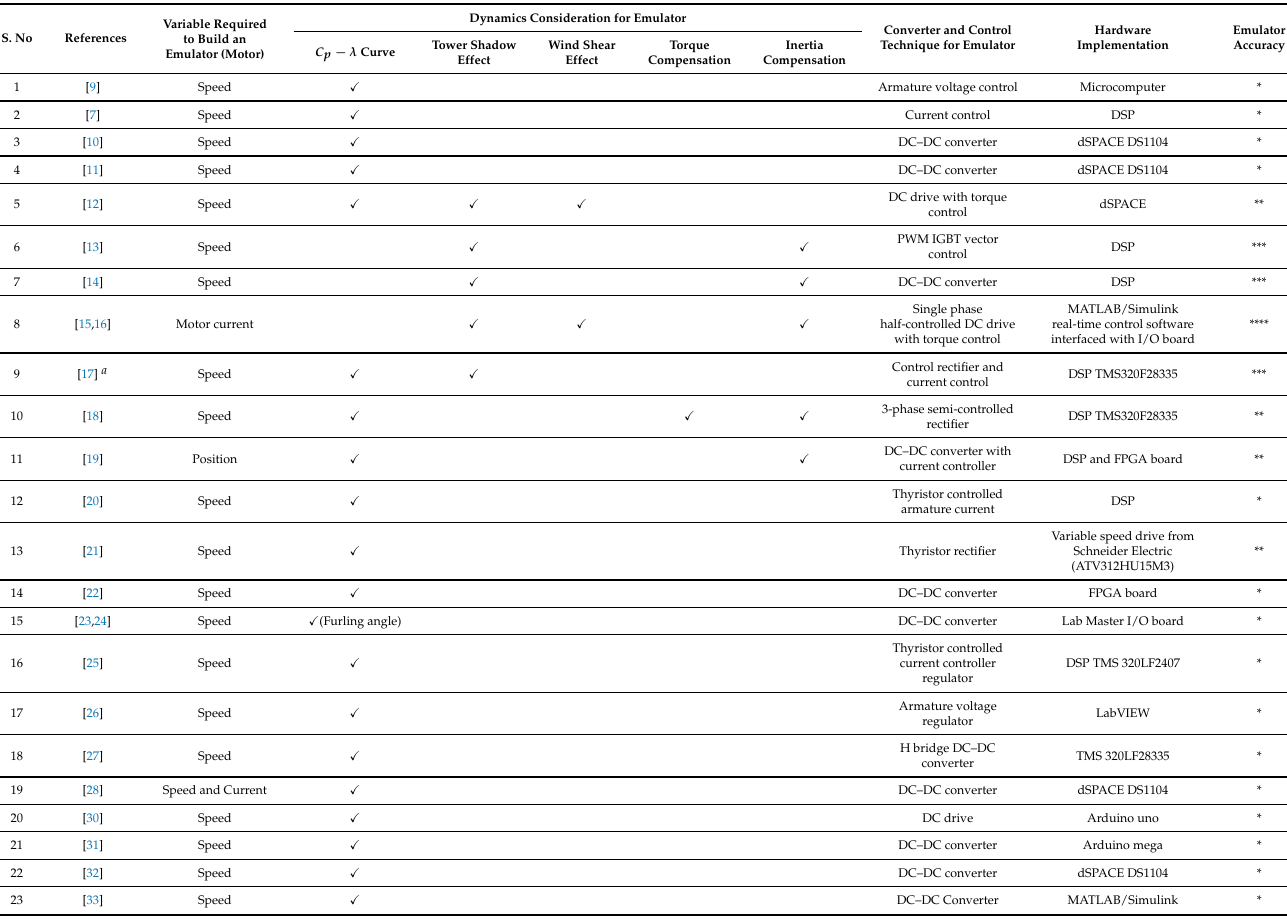
Table 1. Comparative analysis of different WTEs based on DC